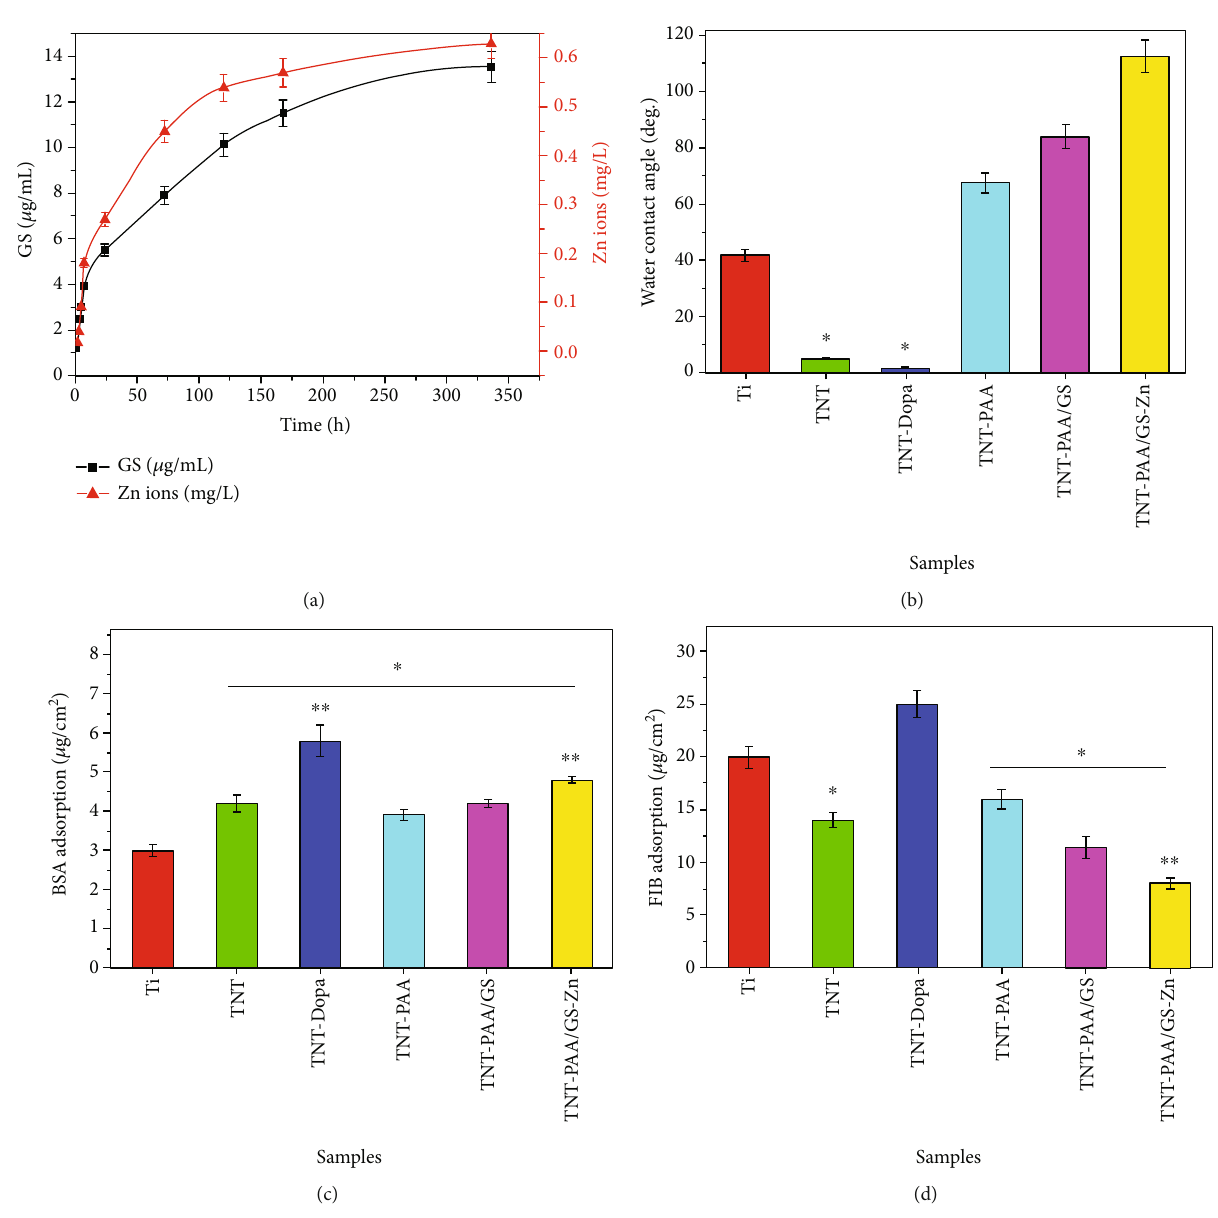
Figure 3: (a) GS and Zn 2+ release pro fi les of TNT-PAA/GS-Zn. (b) The water contact angles of the di ff erent samples. (c, d) show BSA and fi brinogen adsorption of the di ff erent samples, respectively. Statistical di ff erences are indicated by ∗ p < 0 : 05 compared with the Ti group and ∗∗ p < 0 : 05 compared with the Ti and TNT